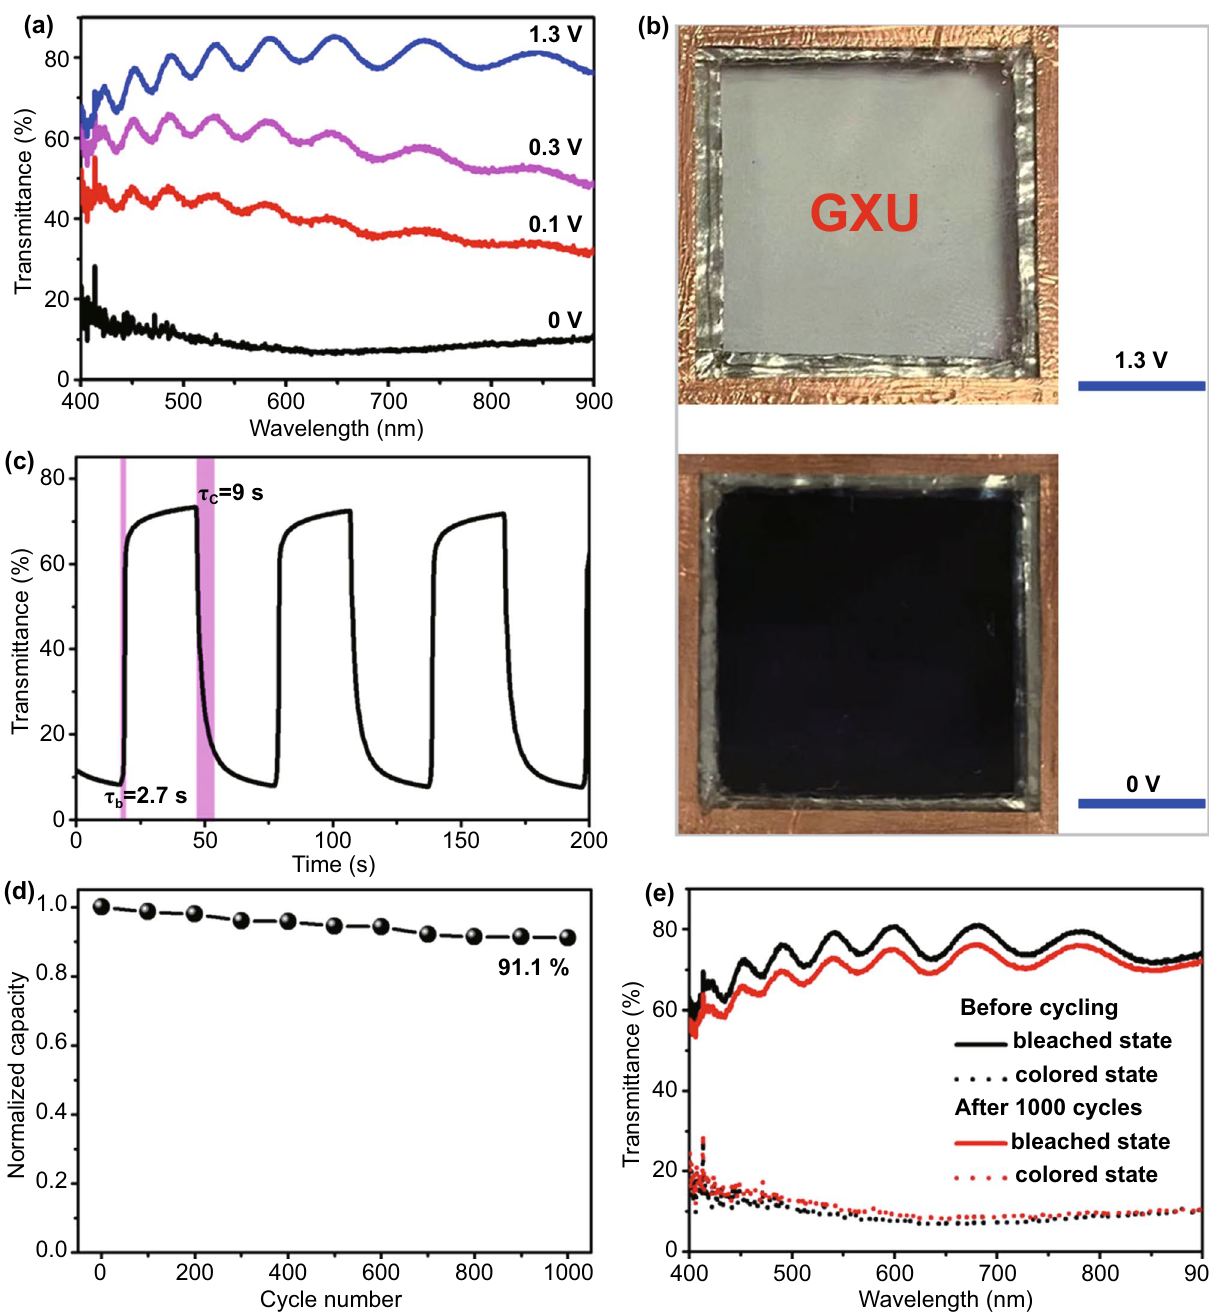
Fig. 5 Electrochromic performance of demonstration device prepared by W4 sample. a Transmittance spectra at different operating voltages. b Photographs at fully bleached and colored state. The blue scare bar is 1 cm. c Real-time transmittance spectra of the device at 550 nm at 1.3–0 V. d Normalized charge capacity profile over 1000 voltammetric cycles at 20 mV s −1 between 0 and 1.3 V. e Optical transmittance spectra before and after 1000 cycles at fully bleached and colored